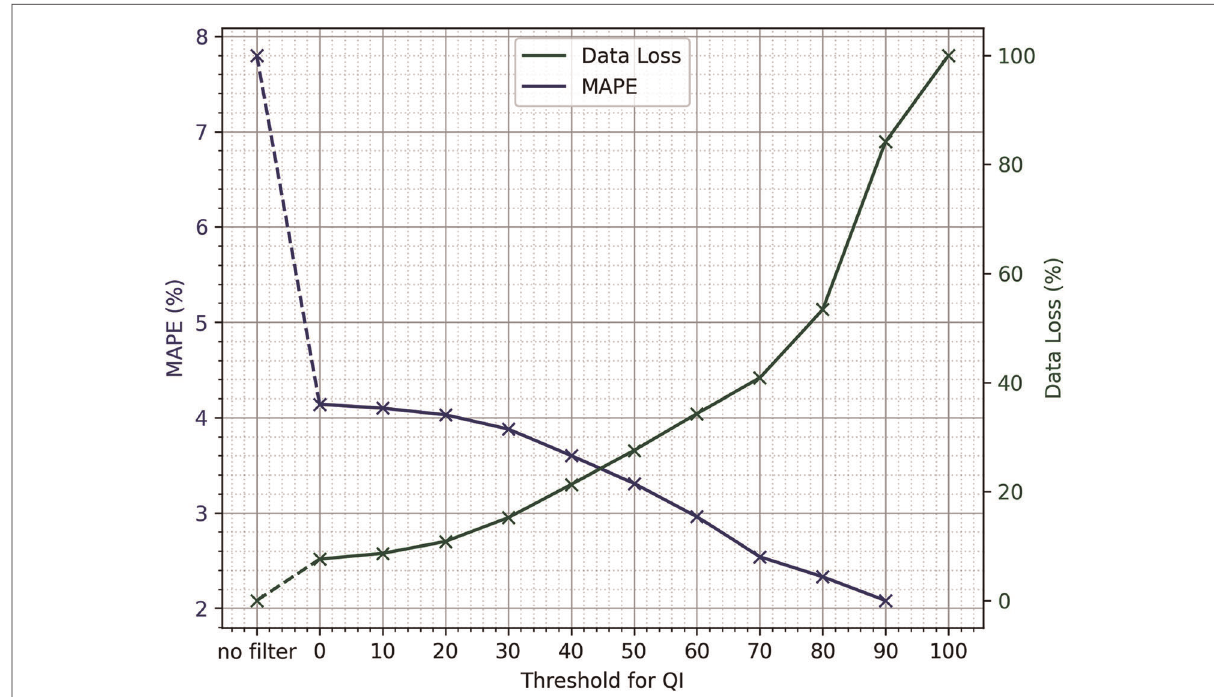
FIGURE 2 Sensitivity analysis of the quality indicator threshold, provided by the in-ear sensor to be used for quality fi ltering, in relation to mean absolute percentage error (MAPE) and data